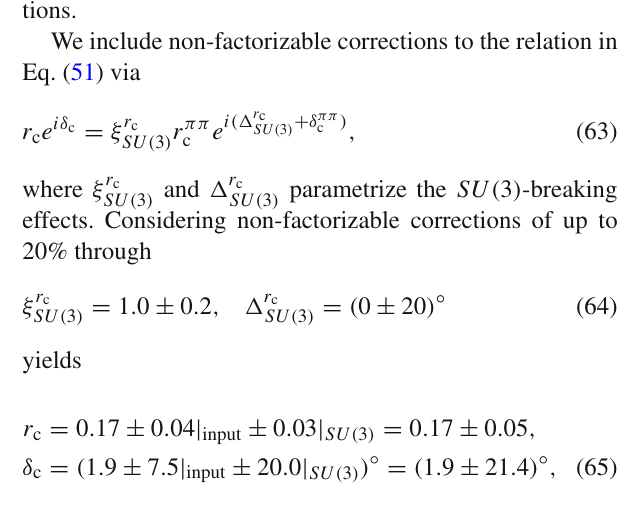
the LHCb upgrade, using the expected uncertainty for the B → ππ observables [4,5], as well as γ = ( 70 ± 1 ) ◦ [4–6] and φ d = ( 43 . 2 ± 0 . 6 ) ◦ [46]. We have shifted the ellipse to get agreement with the blue contour, and observe that both constraints have actually similar precision. In order to guide the eye, we have also added the dashed red ellipse which corresponds to the current